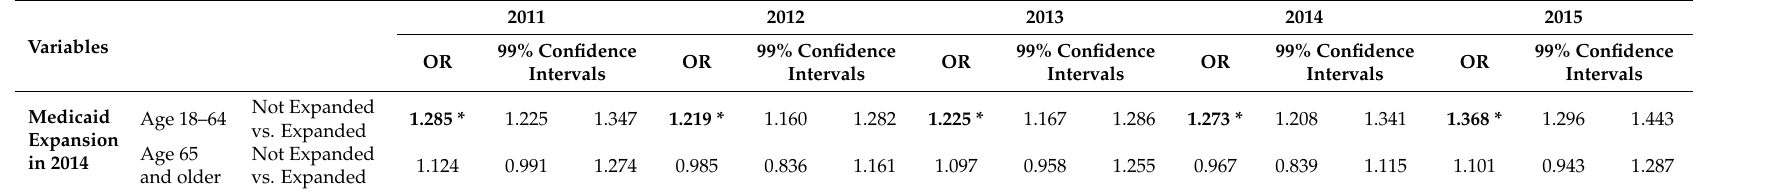
Table 2. Bivariate Analysis for Forgone Care among individuals including state Medicaid expansion.